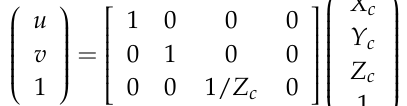
Figure 4. ( a ) Schematic of simulation image generation . ( b ) The image generated from Figure 3a. As shown in Figure 4, the point p  ( ) ZYX ,, CCC